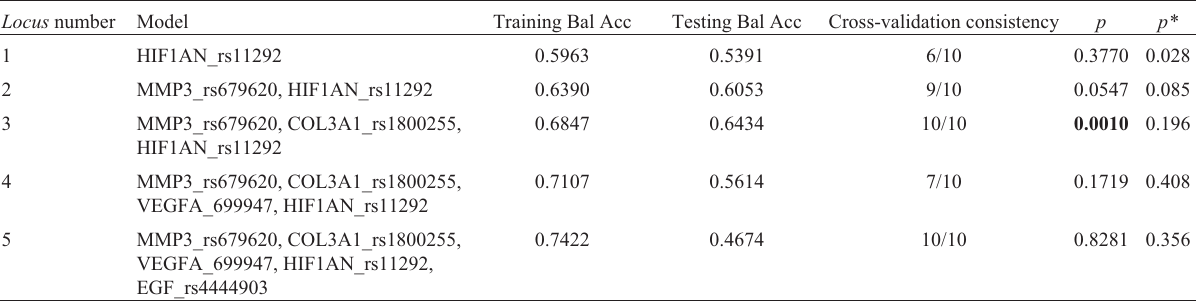
Table 4 - MDR analysis Locus number Model